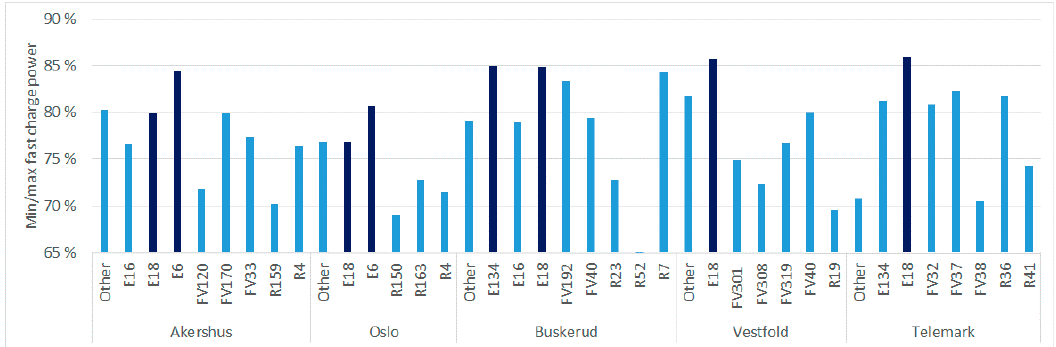
Figure 15. Variation between the month with the max and the min average fast charge power for chargers along motorways (dark blue) and other road types (light blue) in 5 different Counties. Y-axis displays values that are in the interval 65% to 90%. The average monthly value used is the average for 2016 and 2017. E-roads are international main roads linking major cities and regions of Europe, some are motorways, others have the same technical standard as R-Roads. R-roads are national main roads. F-roads are regional roads. Source: Dataset 1 and own analysis.